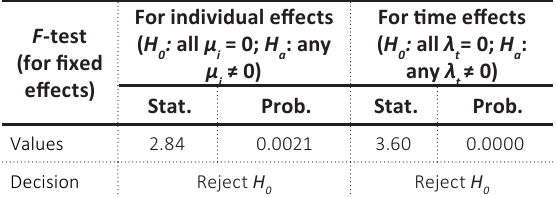
Table 6. F -test results for testing individual and time-specific effects